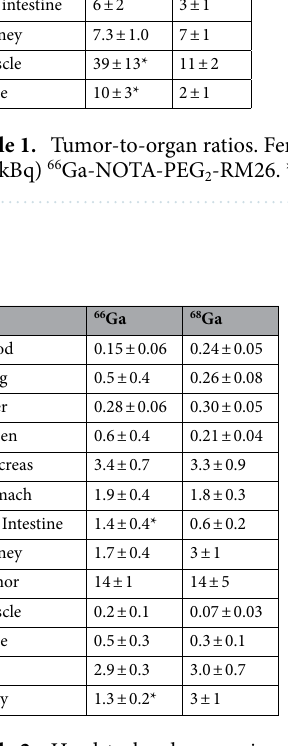
Table 2. Head-to-head comparison of [ 66 Ga]Ga-NOTA-PEG 2 -RM26 and [ 68 Ga]Ga-NOTA-PEG 2 -RM26 3 h pi in female Balb/c nu/nu mice. Data is presented as %ID/g (average ± standard deviation, n = 3–4). *Indicates statistically significant (p < 0.01) differences between